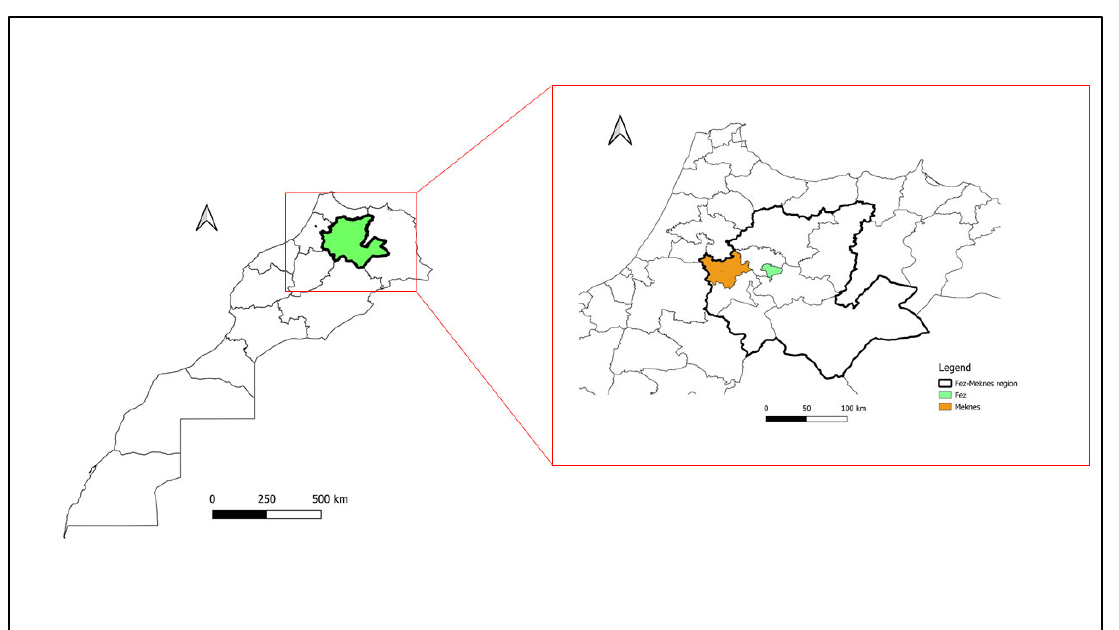
Figure 1. Map showing almond fields examined for wood disease symptoms in Fes Meknes region, Morocco. Prepared using ArcGIS software 10.3.1.